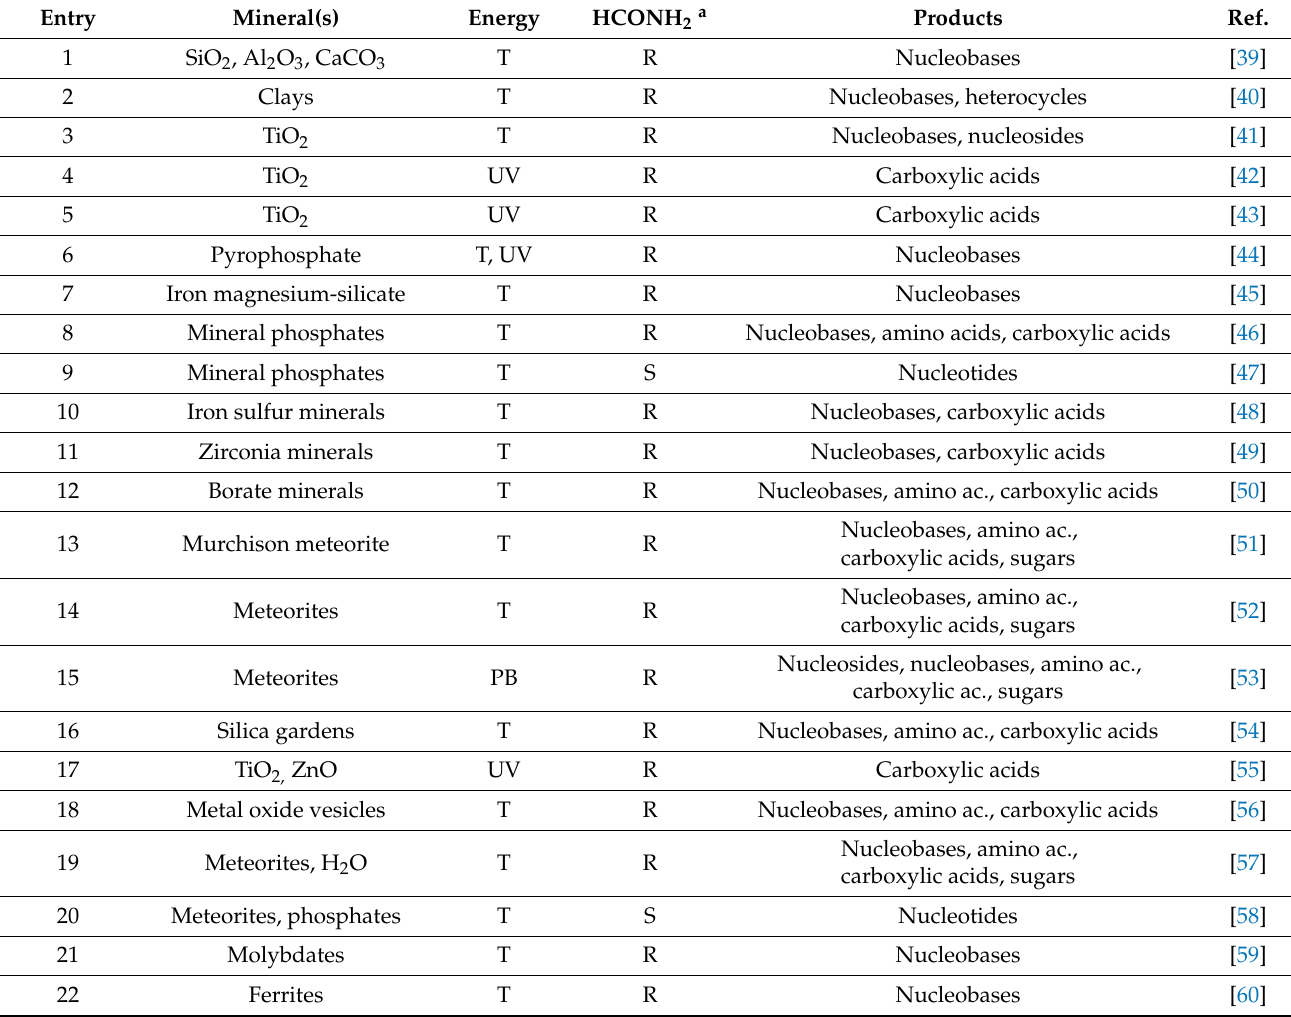
Table 1. Effect of minerals in the prebiotic organic chemistry of HCONH 2